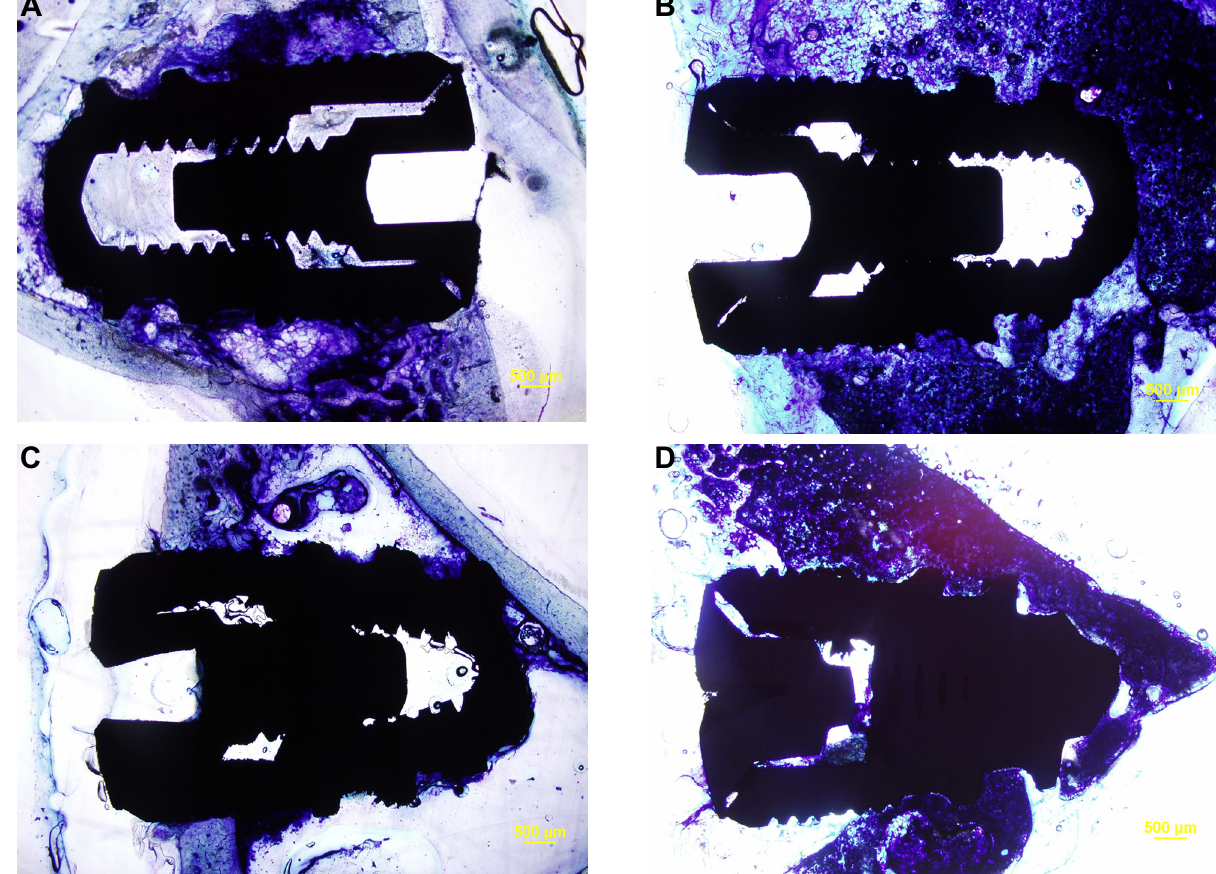
Figure 2A-D - Samples of un-decalcified histologic sections from each group. A: HBO Group at the 4 th week; B: HBO Group at the 8 th week; C: Control group at the 4 th week; D: Control group at the 8 th week. Stain: toluidine blue. Magnification: